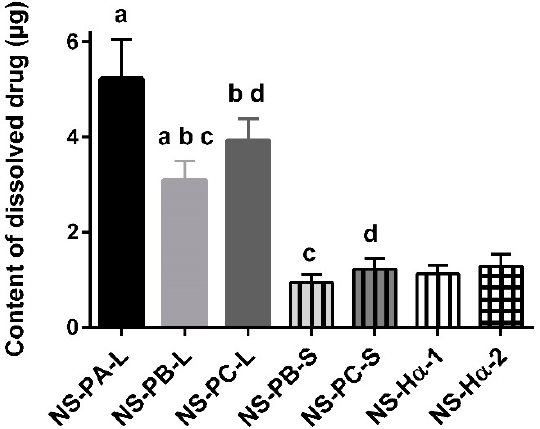
Figure 5. The content of dissolved drug (Mean ± SD, n = 3). a,b,c,d p < 0.05.